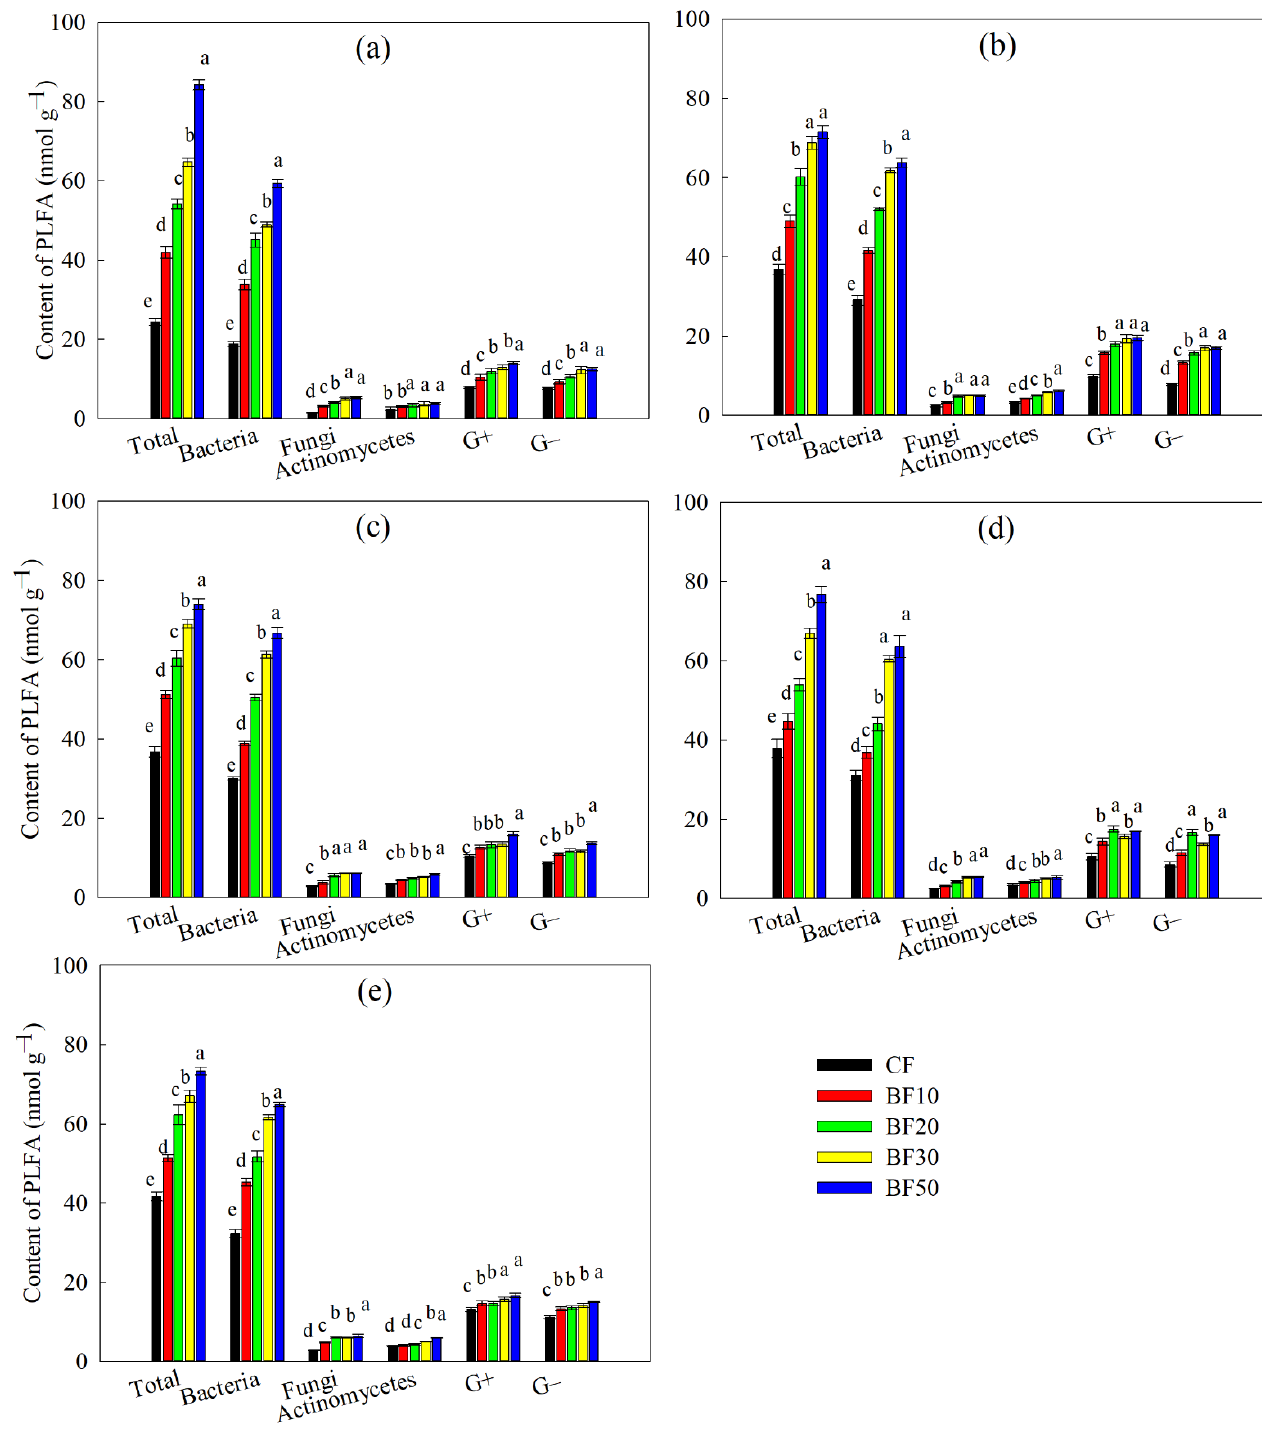
Figure 4. The soil microbial community in >2 mm ( a ), 0.25–2 mm ( b ), 0.053–0.25 mm ( c ), <0.053 mm aggregate fractions ( d ) and bulk soil ( e ) for the five treatments. Error bars represent the standard deviation of the mean ( n = 3). Different lowercase letters above bars for each PLFA indicate significant differences at p < 0.05. CF, BF10, BF20, BF30 and BF50 are defined as in Figure 1. The soil microbial community diversity was significantly affected by Trichoderma bio- fertilizer application and aggregate fractions (Table 3). No significance of Shannon index H was observed among treatments in >2 and 0.25–2 mm aggregate fractions.